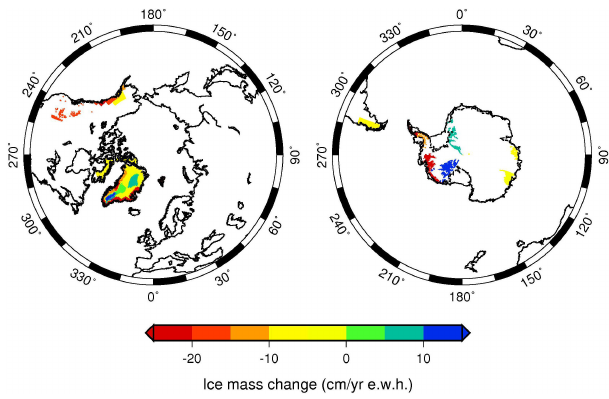
Fig. 1. Spatial distribution of ice mass trends for the regions listed in Table 1 for the period